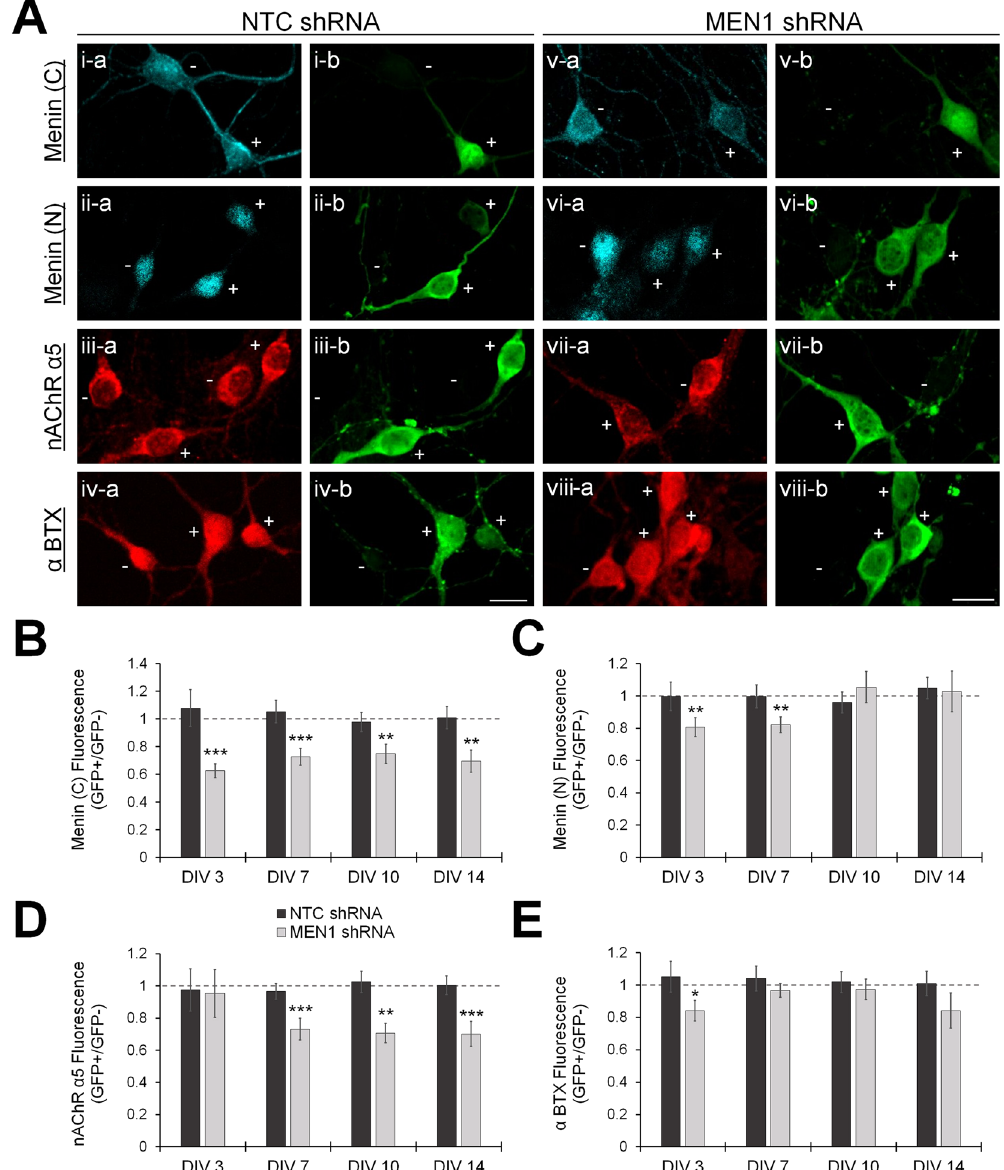
Figure 5. Menin knockdown reduces nAChR α 5 subunit expression. ( A ) ICC characterization of menin and nAChR protein expression in neuronal soma from NTC shRNA and MEN1 shRNA lentivirus transduced hippocampal cultures (n ≥ 4 images, ≥ 2 independent samples; see Table S4; representative images, DIV 7). Untransduced neurons were GFP negative ( − ) and transduced neurons were GFP positive ( + ). The expression of menin was determined with C-terminal (i,v) and N-terminal (ii,vi) epitope antibodies, and nAChRs with a nAChR α 5 antibody (iii,vii), or fluorophore-tagged α -BTX (iv,viii; α 7-nAChR). ICC labels are shown in a (left panels), and GFP fluorescence is shown in b (right panels). Scale bars, 20 μ m. ( B–E ) Summary data, normalized somal fluorescence intensity of α -C-terminal menin ( B ), α -N-terminal menin ( C ), α -nAChR α 5 ( D ), and α -BTX ( E ), in GFP + neurons relative to GFP- neurons at DIV 3–14 (ROIs: n ≥ 12 each; see Table S4). Dashed lines represent a 1:1 ratio indicating no change. Asterisks, statistical significance (independent t-test or Mann- Whitney U test); * P < 0.05. ** P < 0.01. *** P <